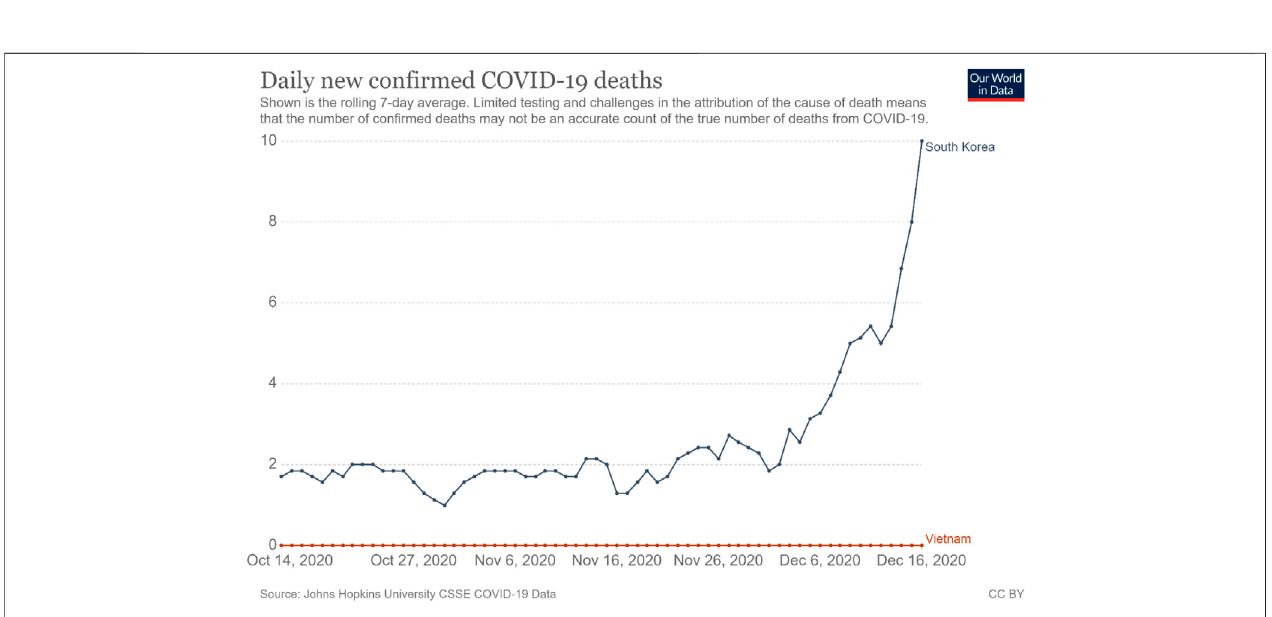
FIGURE 4 | COVID-19 con fi rmed cases in vietnam and the RoK between 15 October 2020 and 15 December 2020 (see Ritchie, et al., 2020).